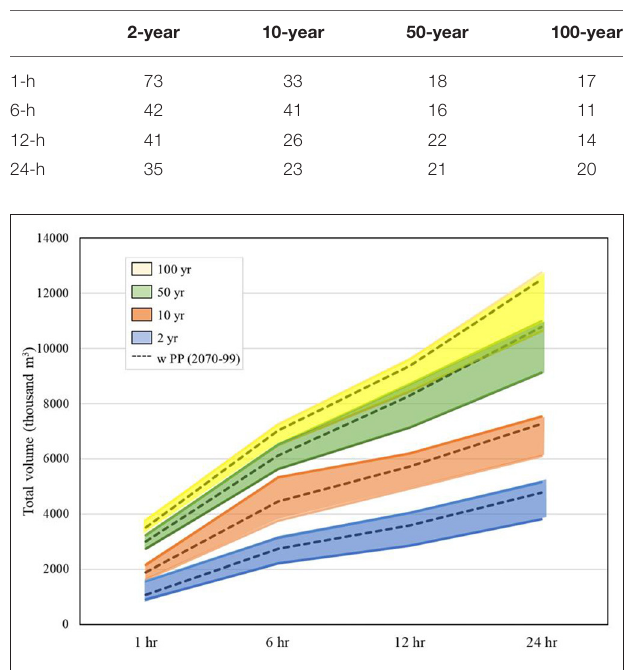
FIGURE 4 | Comparison of total CSO volumes under different scenarios. Shaded areas are the volumetric differences per return period bounded by CSO volumes under 2070–2099 timeframe (upper border) and 1970–1999 timeframe (lower border). Dotted lines represent the PP deployment scenarios for the 2070–2099 timeframe.